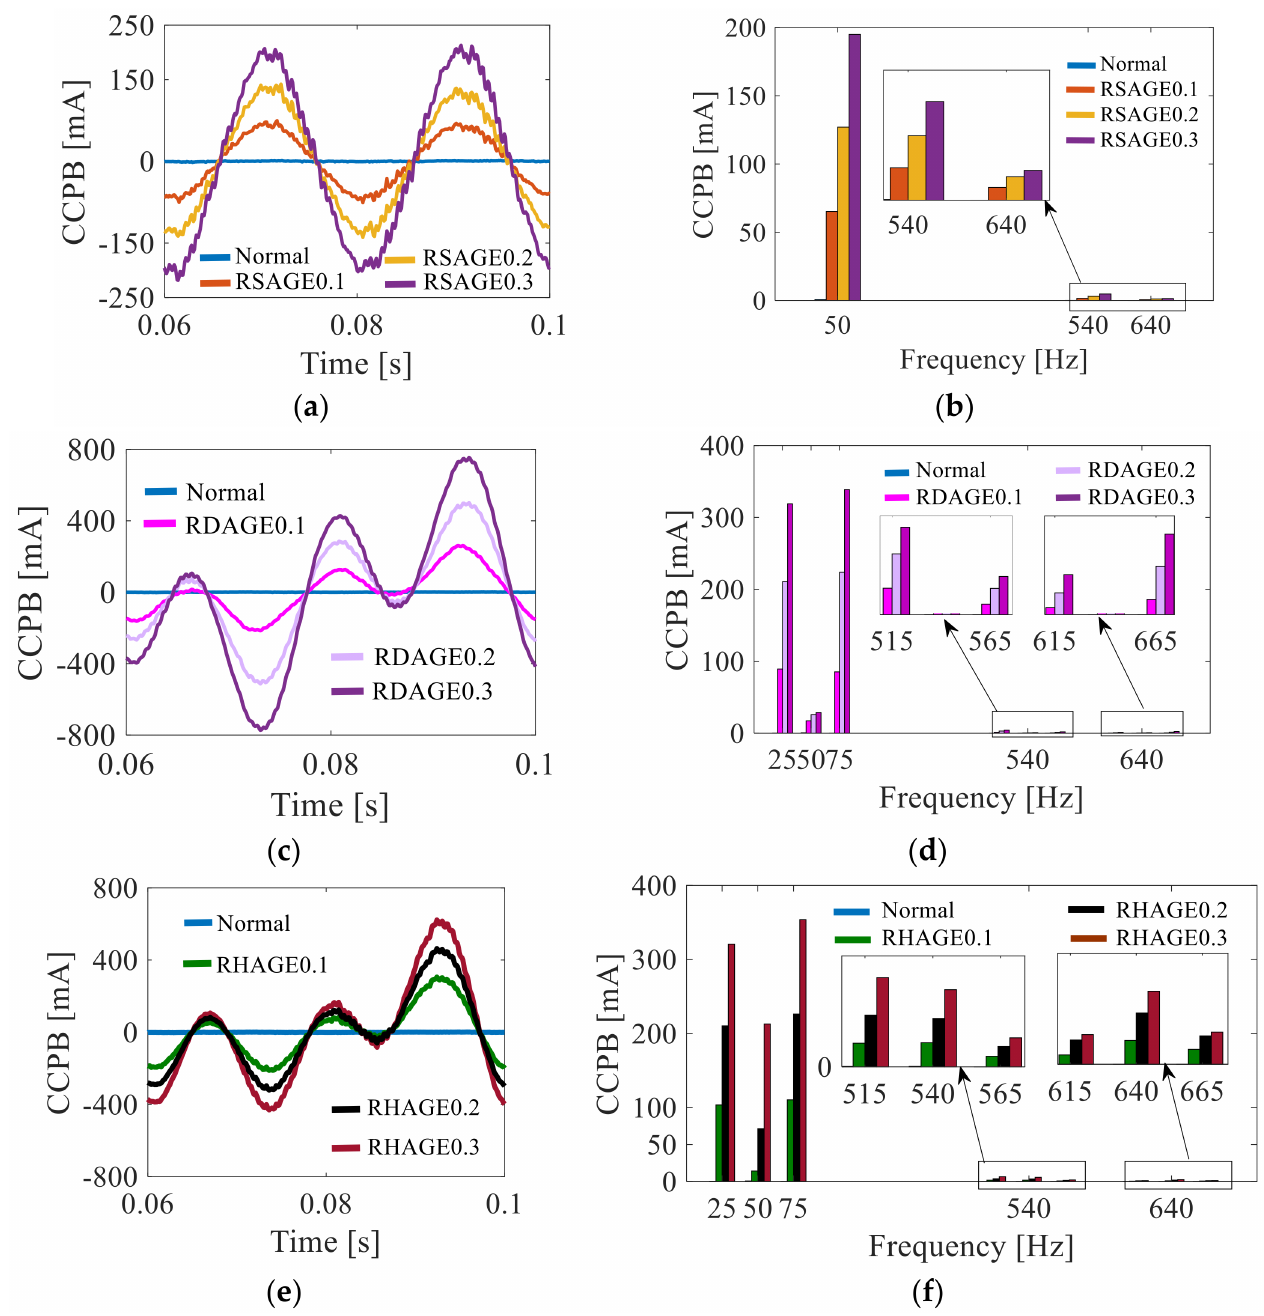
Figure 8. The stator CCPB in normal and RAGE conditions: ( a ) the time domain of stator CCPB in RSAGE; ( b ) the frequency domain in RSAGE; ( c ) the time domain of stator CCPB in RDAGE; ( d ) the frequency domain in RDAGE; ( e ) the time domain of stator CCPB in RHAGE; ( f ) the frequency domain in